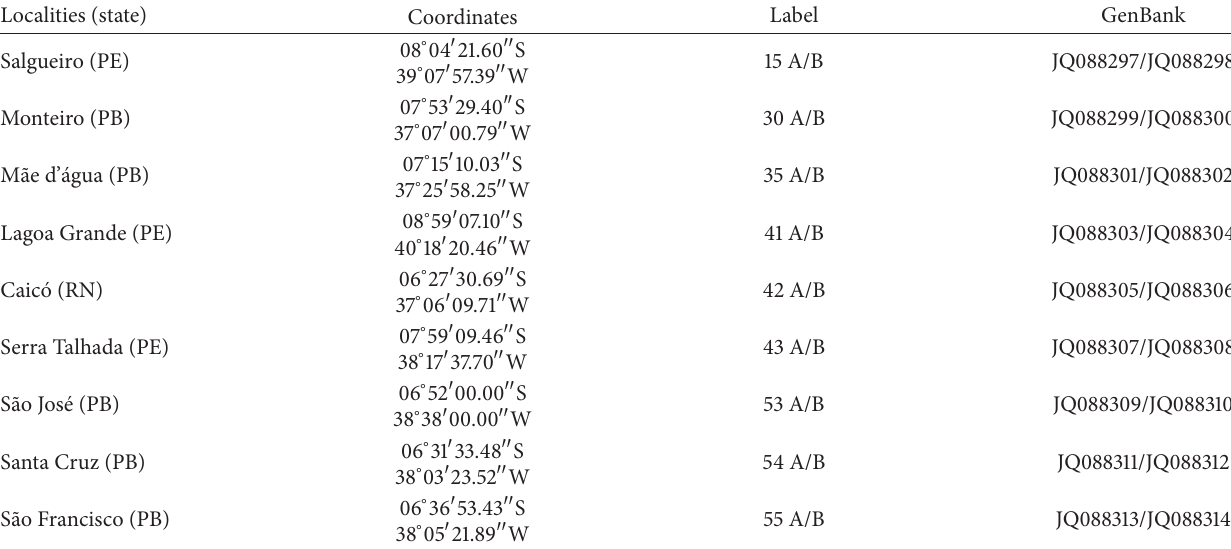
Table 1: Triatoma brasiliensis collection sites, coordinates, labels of selected sequences, and GenBank access numbers. Localities (state) Coordinates Label